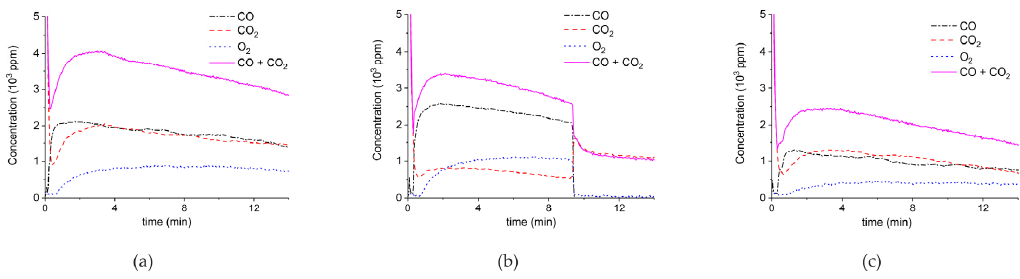
Figure 5. Concentration of the products of decomposition of sample A ( a ), sample B ( b ), and sample C ( c ), with a temperature of 630 °C in pure argon and flow rate of 30 mL/min; plasma power is 2.1 ± 0.1 W.